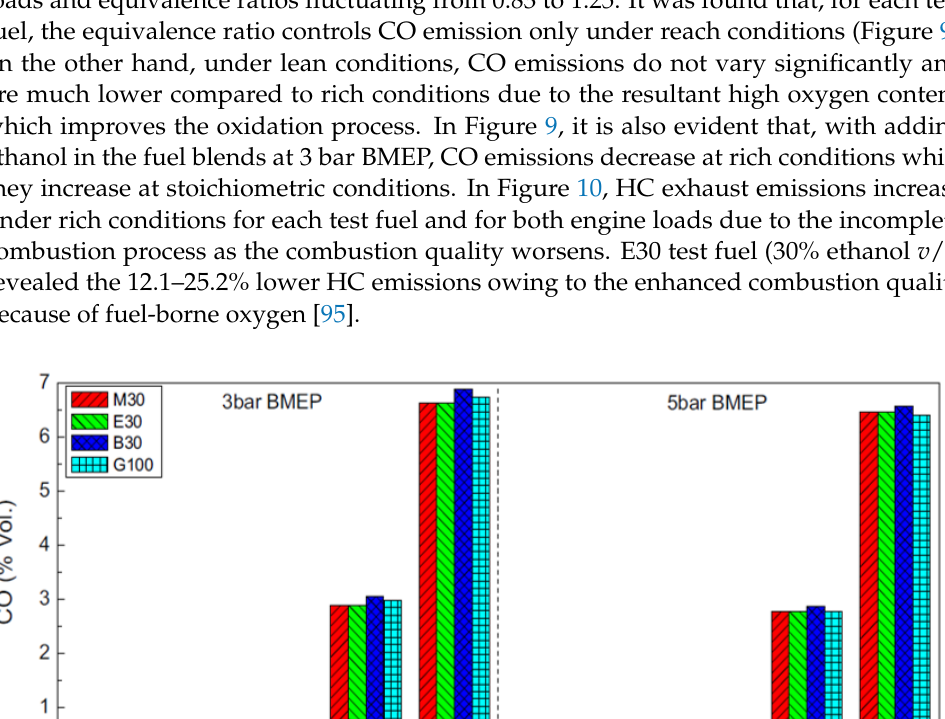
Figure 8. Variation in HC emissions with alcohol content in the blends at 3 bar BMEP and equivalence ratio φ = 1: comparison between methanol, ethanol and butanol [95]. Reproduced with permission from Applied Thermal Engineering; published by Elsevier, 2017. License Number: 5094081168292.